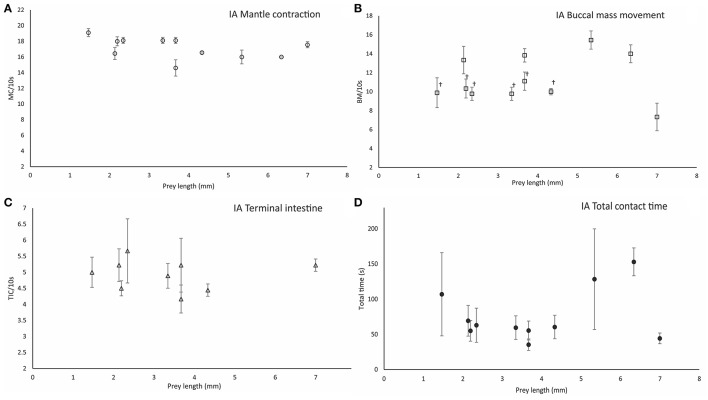
Parameters measured during ineffective attacks (IA). Mantle contraction frequency (MC/10 s) (A), buccal mass movement frequency (BM/10 s) (B), terminal intestine contraction frequency (TIC/10 s) (C), and total contact time between paralarvae and prey (TCT/10s) (D). Prey types are grouped by prey size in length (mm). Symbols (†) indicate significant differences (one-way ANOVA, p < 0.05) between prey types. Vertical bars represent the standard deviation of the mean for each variable.